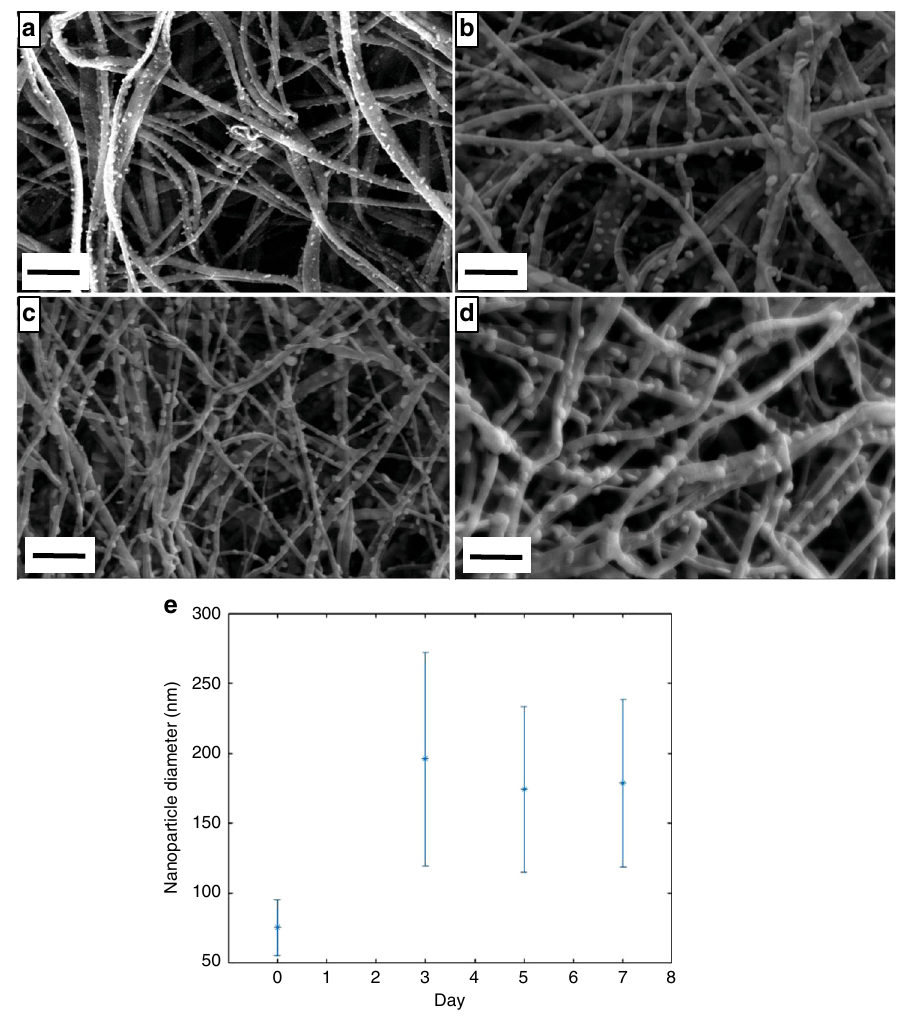
Fig. 4 Effects of constant relative humidity on the electrospun samples over time. The caesium dihydrogen phosphate-polyvinylpyrrolidone-polyaniline (CDP-PVP-PANI) composites show changes in the nanoparticle diameter over time during constant temperature and humidity (23 °C and 35% relative humidity). a As-spun sample. b Day 3. c Day 5. d Day 7. Scale bars represent 1 µ m. e Plot showing the size and size distribution evolution over time. Error bars show standard deviation ( n = 106). Source data are provided as a Source Data fi